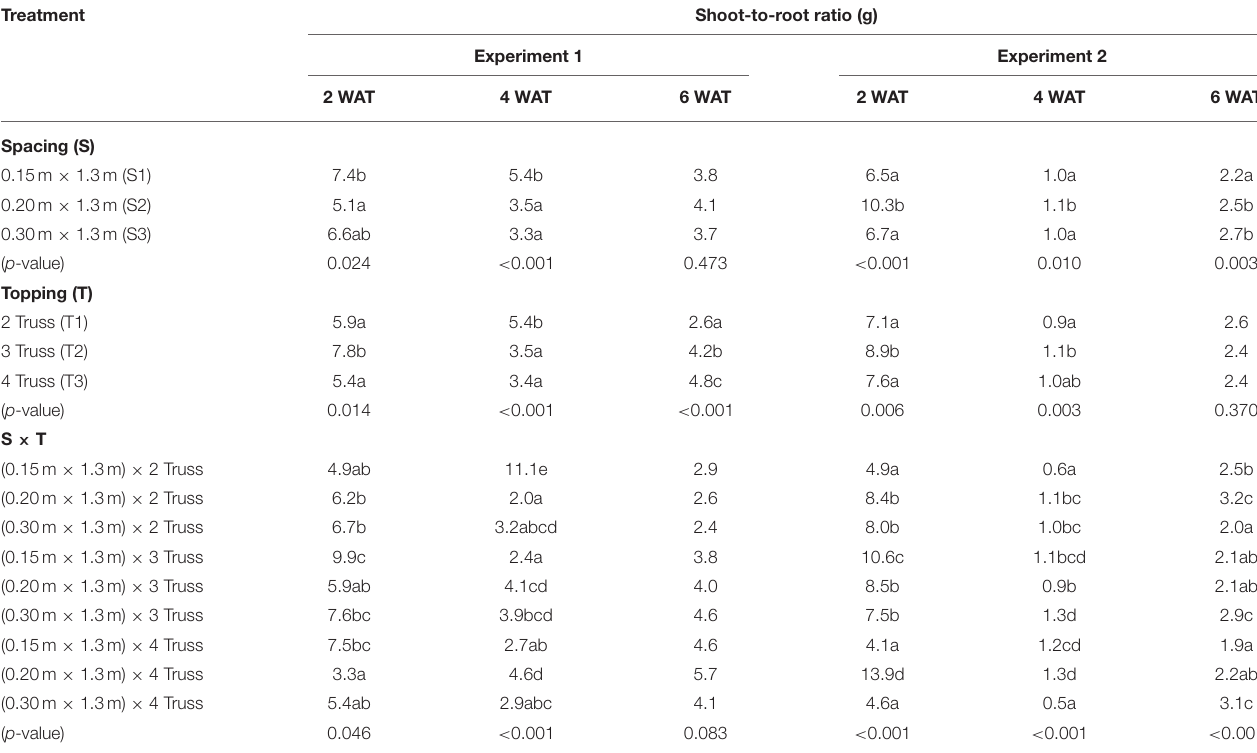
TABLE 6 | Effect of spacing and topping on plant shoot-to-root ratio of Solanum lycopersicum under greenhouse conditions.